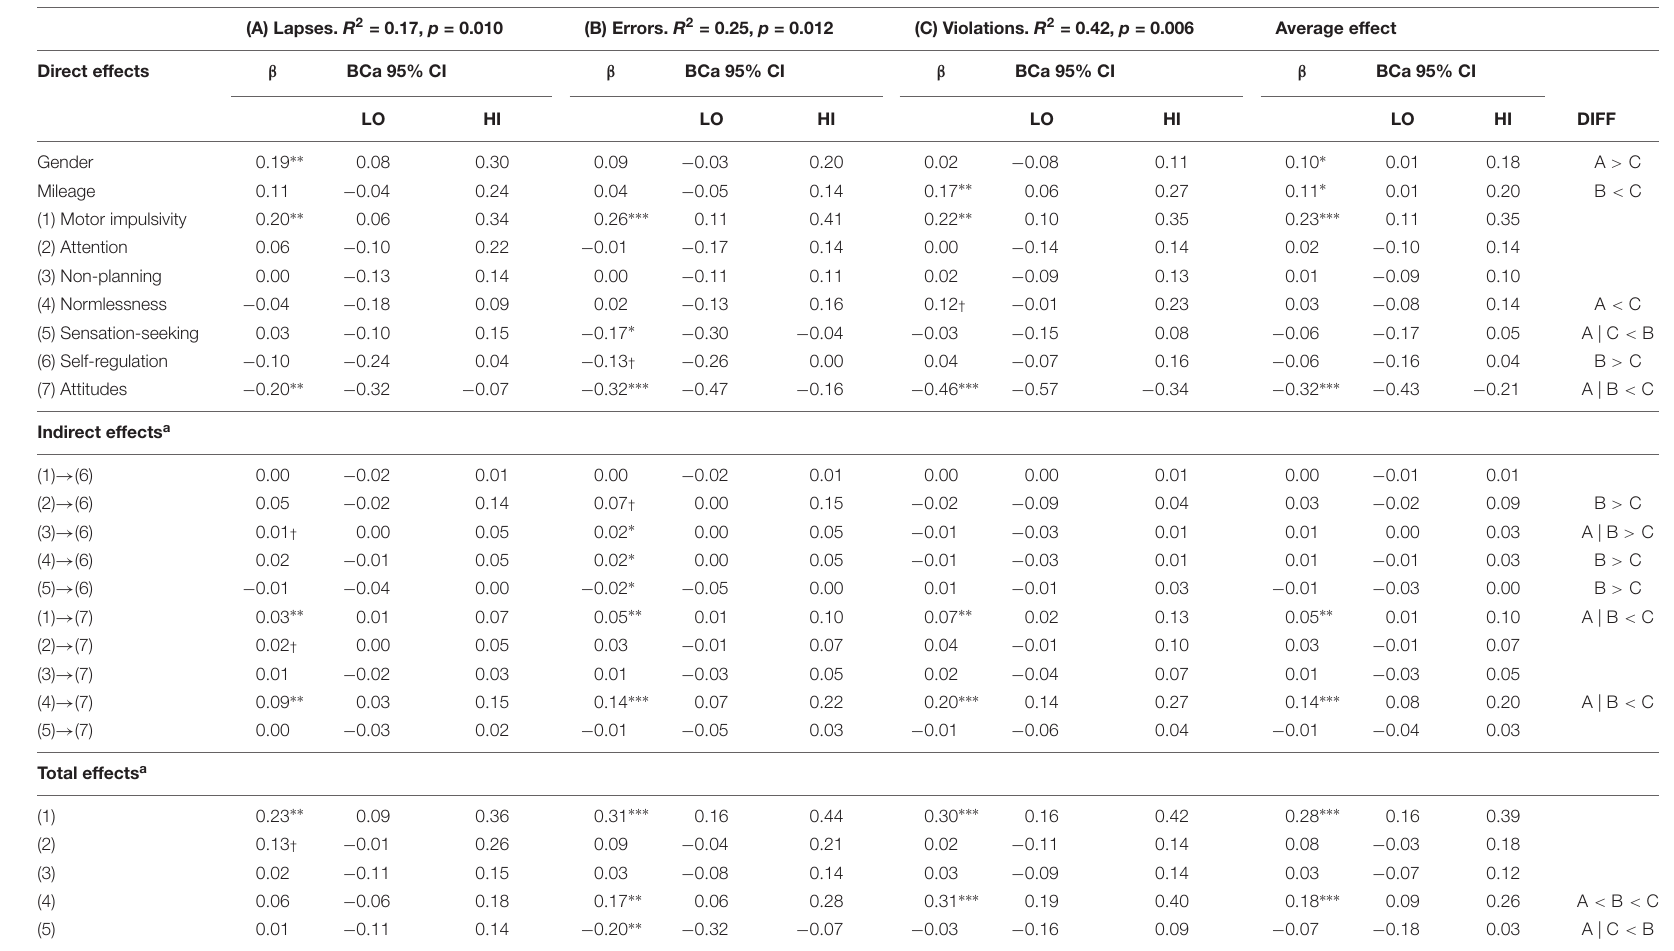
TABLE 2 | Path model results for the direct and indirect effects of system 1 traits on self-reported aberrant driving behavior. (A) Lapses. R 2 = 0.17, p = 0.010 (B) Errors. R 2 = 0.25, p = 0.012 (C) Violations. R 2 = 0.42, p =